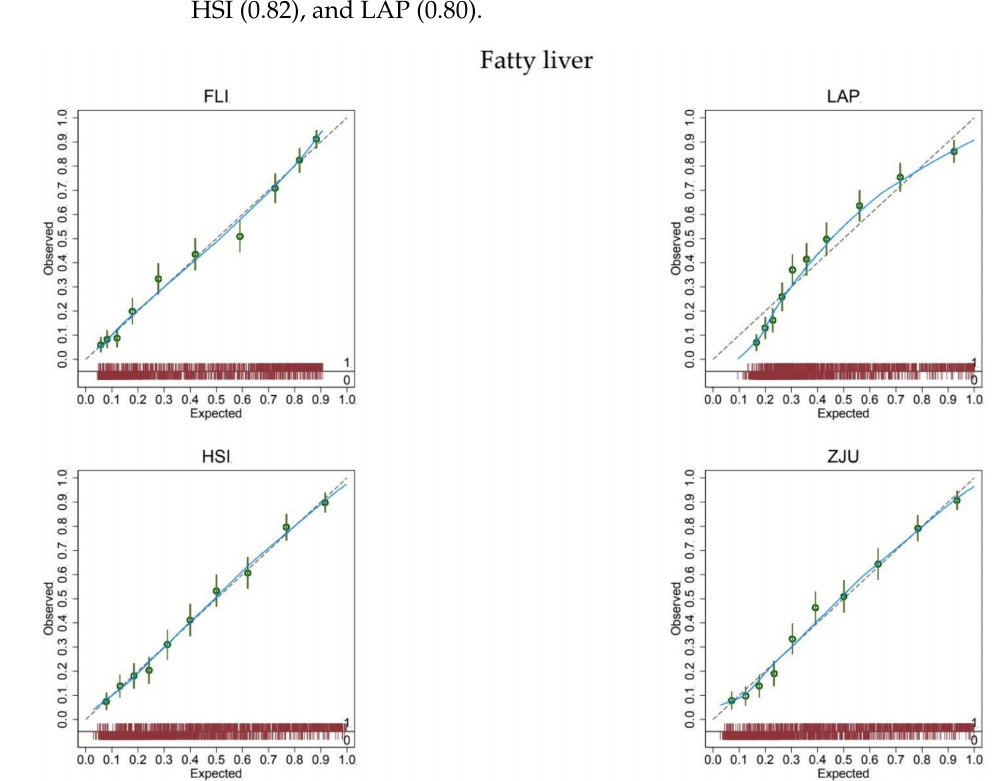
Figure 1. Calibration plots for the diagnosis of fatty